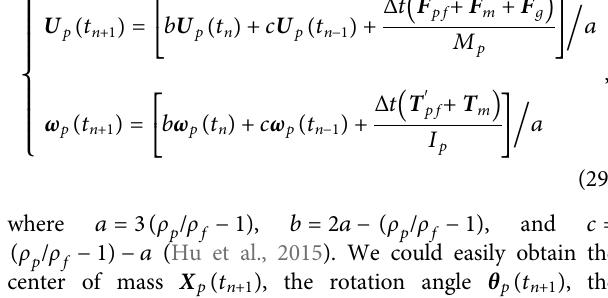
Frontiers in Materials |